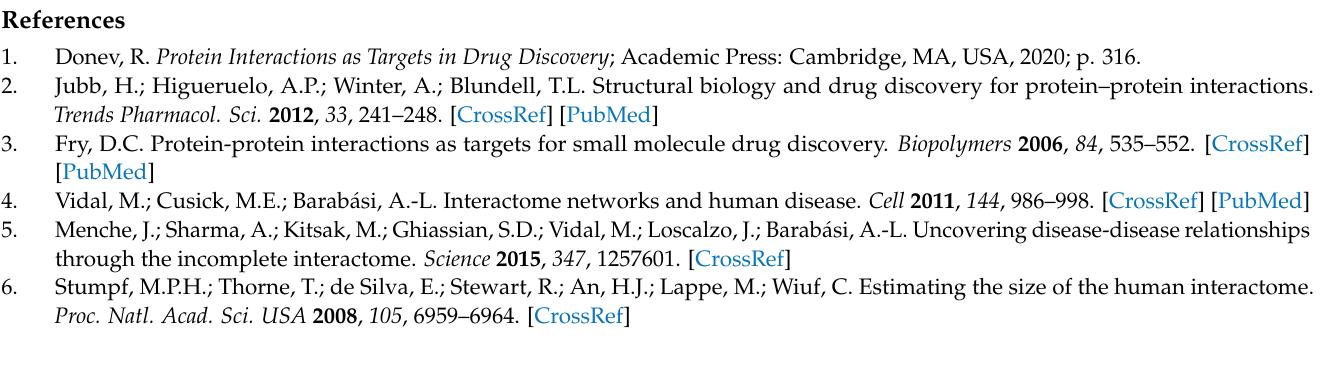
screening protocol; Figure S2: Binding evaluation of M1 structure-similar molecules; Figure S3: Binding evaluation of M2 structure-similar molecules; Figure S4: Binding evaluation of M3 structure- similar molecules; Figure S5: Binding evaluation of de-novo synthesized M1 derivatives; Figure S6: ITC titration curves of non-binding de-novo synthesized M1 derivatives; Figure S7: Binding evaluation of de-novo synthesized M2 derivatives; Figure S8: ITC titration curves of non-binding de-novo synthesized M2 derivatives; Figure S9: Cellular activity and viability; Figure S10. Pharmacophore